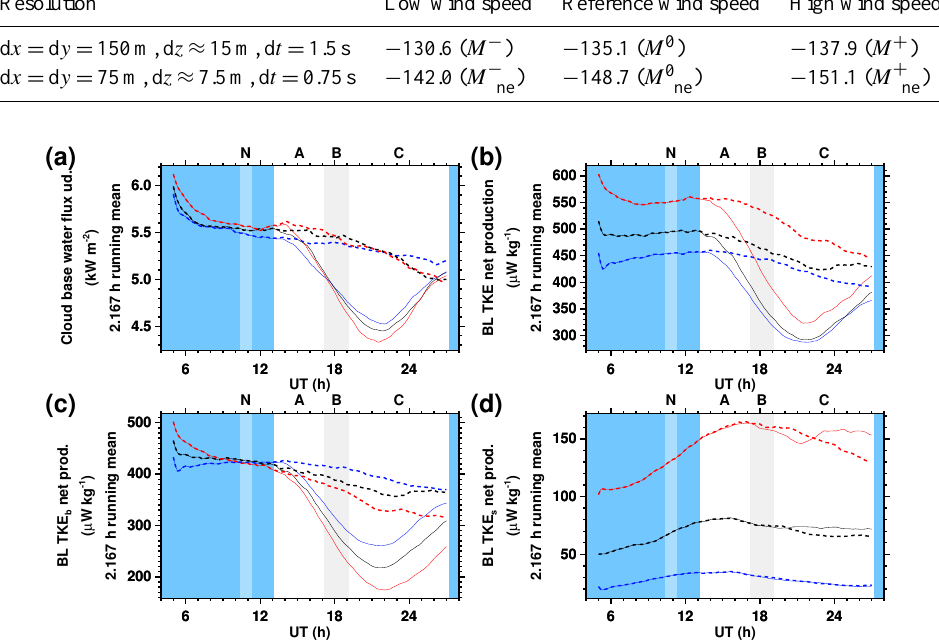
Figure 9. Wind speed and the diurnal cycle. Time series from simulations M − (blue), M 0 (black), M + (red), solid curves, and from simulations M − (blue), M 0 (black), M + (red), dashed curves. The cloud base water flux in updrafts is given per horizontal surface dark dark dark area of the domain. A low-pass (running mean) filter was applied where indicated to reduce